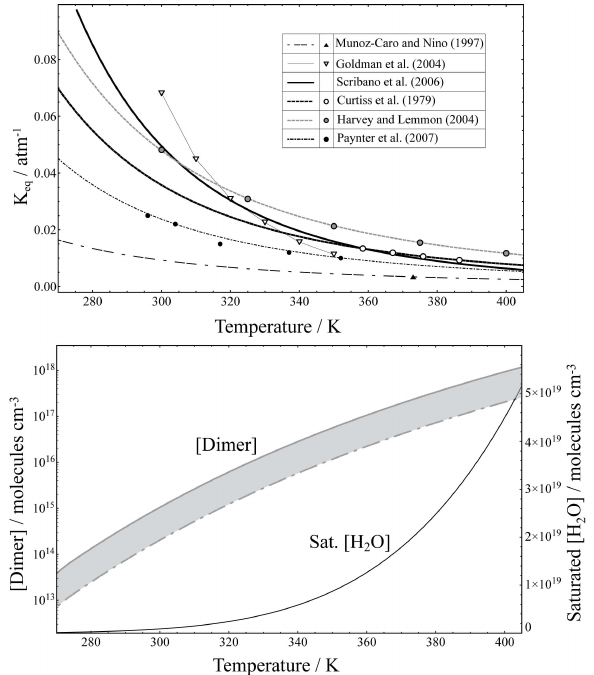
Fig. 1. Upper panel: Temperature dependence of the equilibrium constant for formation of the water dimer. Lower panel: number concentration of water monomer at saturation as a function of tem- perature (black line; right axis), and corresponding number concen- tration of the dimer (shaded area; left axis) calculated using the var- ious equilibrium constants above for an assumed relative humidity of